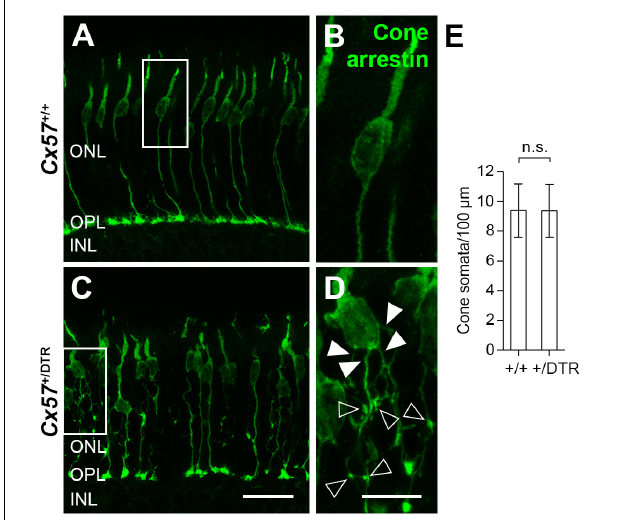
FIGURE 3 | Cone neurite sprouting in adult horizontal cell-ablated mice. (A–D) Vertical sections of Cx57 + / + and Cx57 + / DTR mice (P56) were labeled with antibodies against cone arrestin. While cones in wild-type mice had one axon with a single terminal (A,B) , cones in horizontal cell-ablated mice had branched axons with numerous terminals (open arrowheads) (C,D) . In some cases, several axons emerged from one soma (white arrowheads) (C,D) . (E) Quantification of cone somata in vertical sections of wild-type ( n = 3) and horizontal cell-ablated retinae ( n = 3) (P56). p = 0.9736, t -test. Values are presented as mean ± SD. Scale bars, 25 µ m (C) , 10 µ m (D)